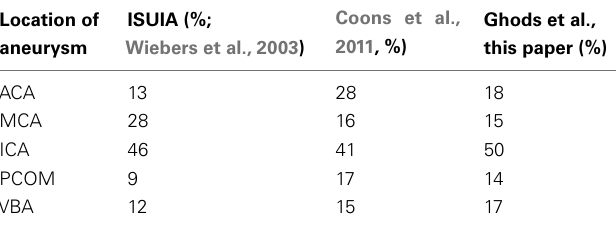
Table 4 | Data of both ruptured and unruptured aneurysms from ISUIA and Coons compared to current